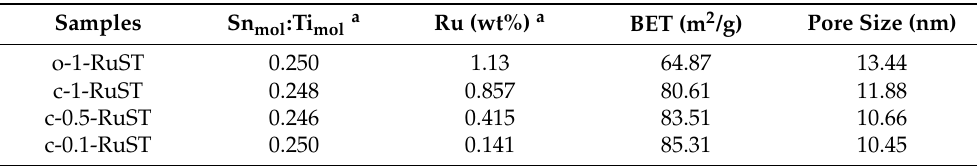
Table 2. Characterization results of some physico-chemical properties of RuST series samples.